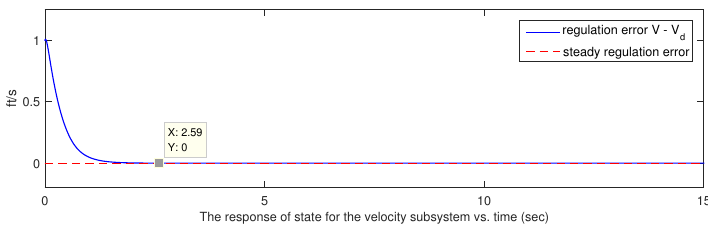
Figure 2. The state error response of the velocity subsystem.